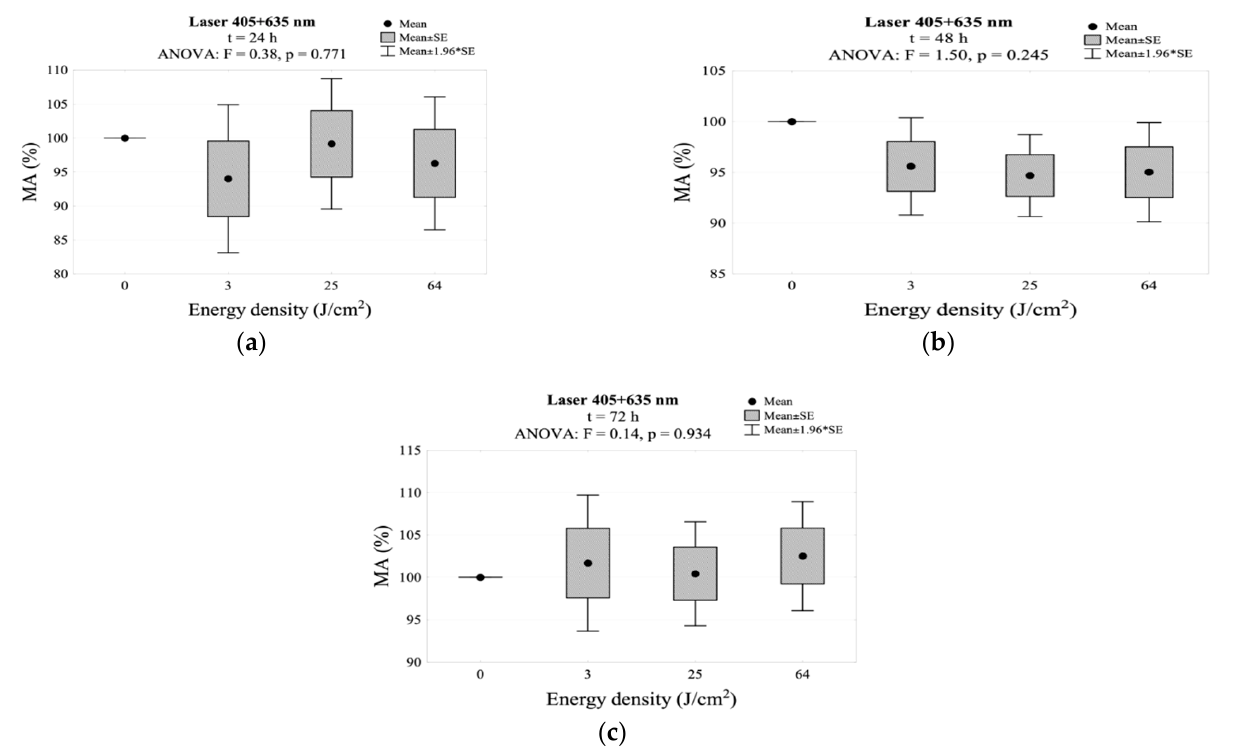
Figure 5. MA measured ( a ) 24 h, ( b ) 48 h, and ( c ) 72 h after irradiation using the 405 + 635 nm laser. In the group simultaneously irradiated with two wavelengths (450 + 635 nm), after 24 and 48 h for all energy densities, a decrease in MA below 100% was noted, without a statistical difference compared to the control group. It seems interesting that despite the initial decrease in the MA value, it slightly increased to 103.8% after 72 h in the group irradiated with an energy density of 25 J/cm 2 . However, this difference was not statistically significant. The results regarding the MA value using two wavelengths (450 + 635 nm) incubation after irradiation for mitochondrial activity is shown in Figure